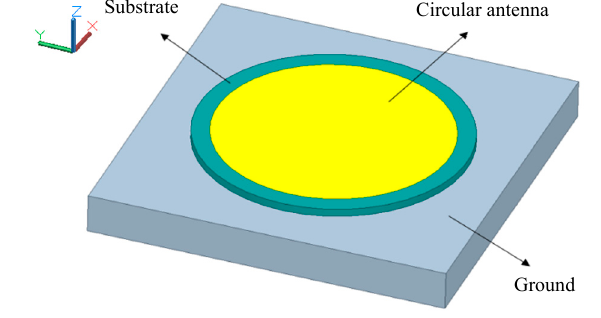
Figure 1. Circular antenna .